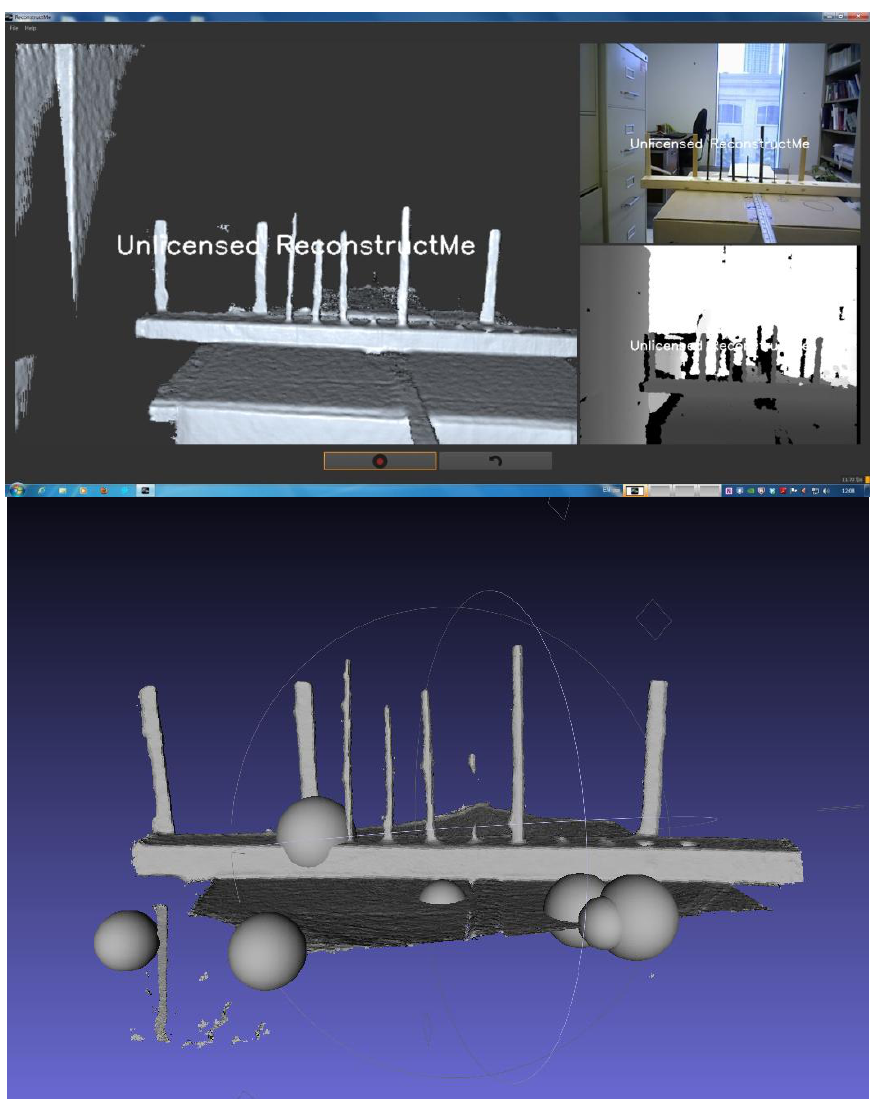
Figure 3. Top: screen capture of ReconstructMe showing the generated mesh (left), the RGB camera output (top right) and the depth camera output (bottom right). Bottom: resulting mesh from ReconstructME viewed in MeshLab. Spheres are added to generated meshes if a license has not been purchased. From left to right starting at the second vertical object: 7, 8, 10, 5, 13, 3 and 2